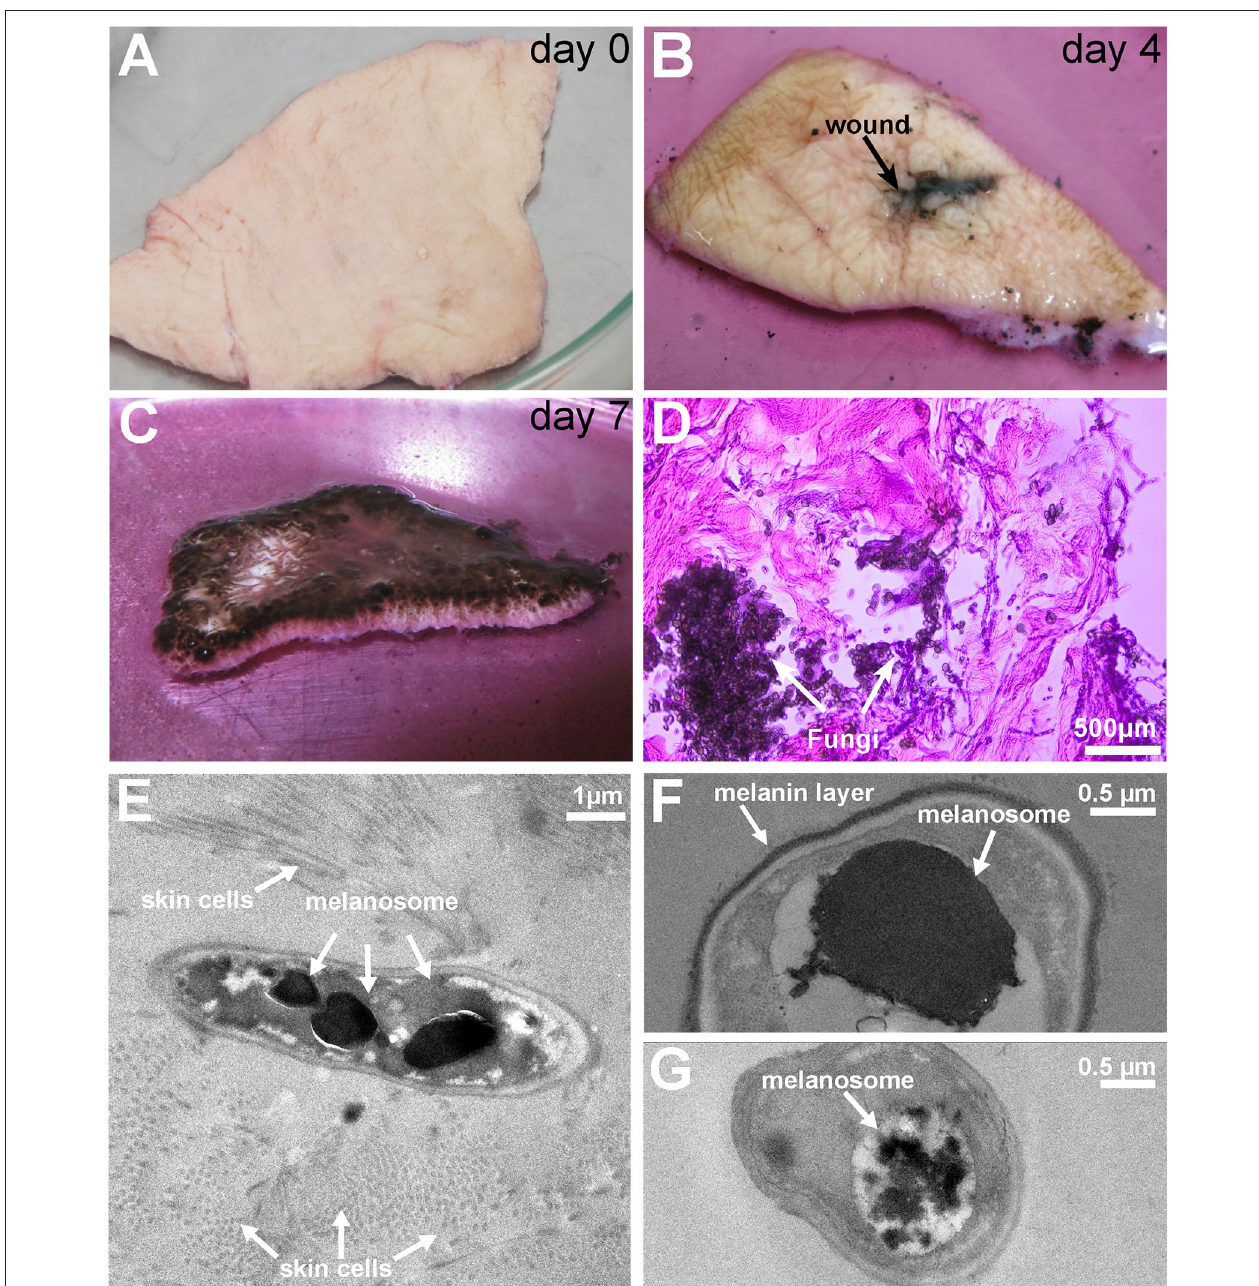
FIGURE 1 | Pictures of the colonization and invasion of ex-vivo skin samples by Exophiala dermatitidis at 37 ◦ and TEM pictures after 1 week. (A) At day 0, ex-vivo skin samples were cut in approximately 5 × 5 cm pieces and inoculated with Exophiala dermatitidis . (B) At day 4 growth in and around the wound (black spot in the middle) could already be observed. (C) At the end of the experiment (day 7), the upper skin surface was completely covered by the fungus. (D) HE staining of the infected skin. Skin is stained in pink and the fungus is stained in deep purple. After 7 days Exophiala dermatitidis had penetrated deep inside the skin. (E) Melanosomes inside a fungal cell surrounded by skin cells. (F) Vacuole filled with flocculated melanin and melanin layer surrounding the cell. (G) Flocculated melanin in a vacuole.